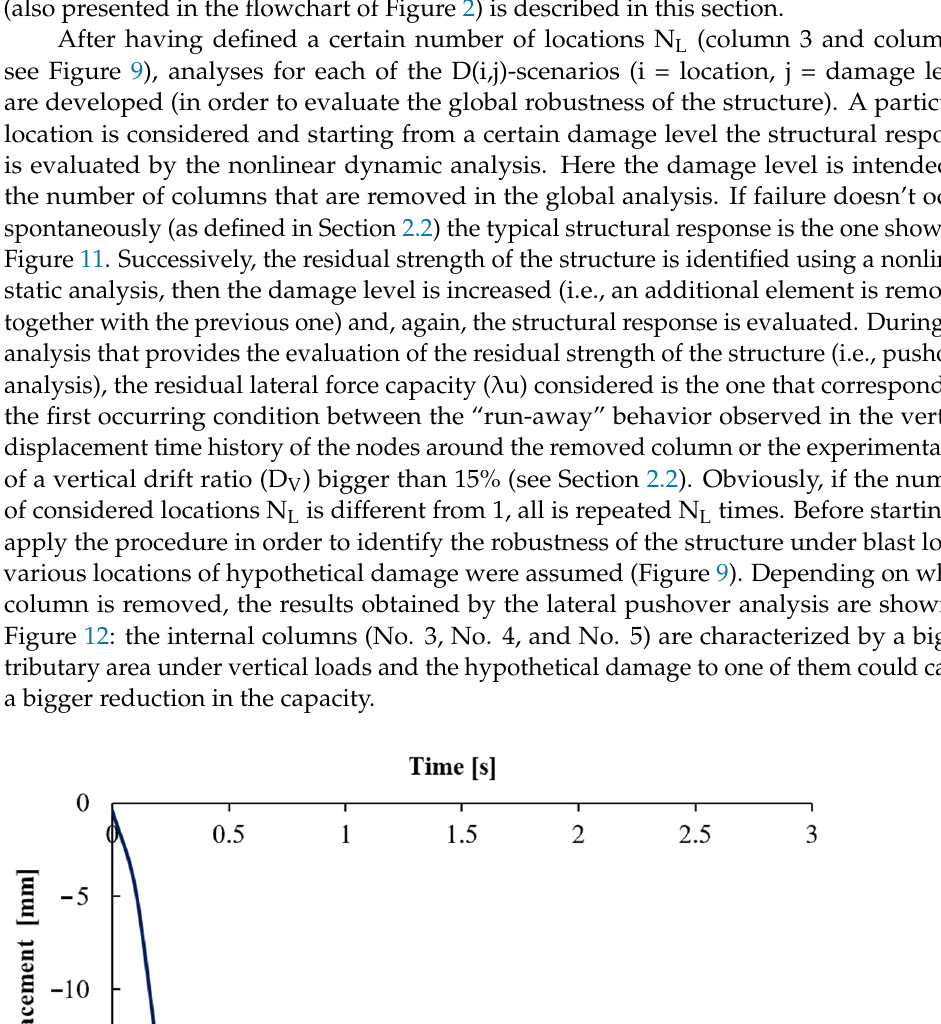
Figure 11. Typical displacement of the node at the top of column